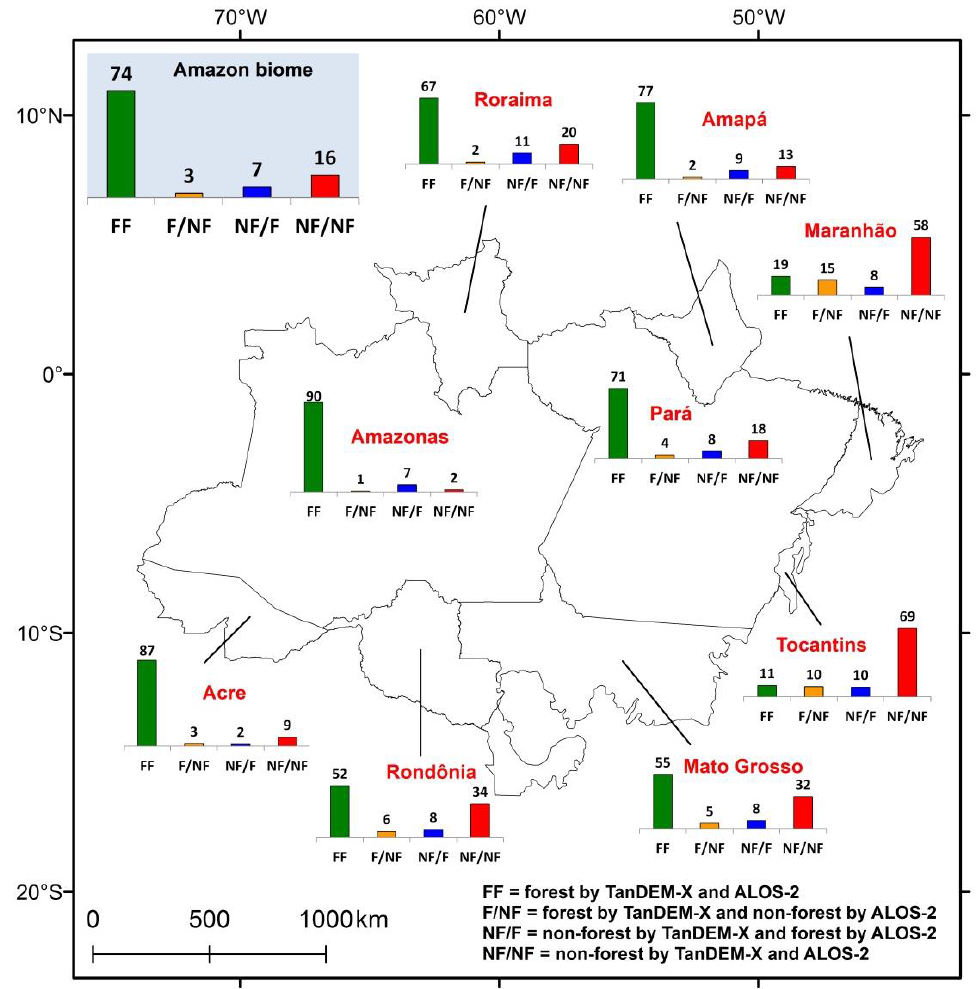
Figure 9. Percentage of pixels classified by the TanDEM-X and ALOS-2 as: forest (FF); non-forest (NF/NF); forest and non-forest (F/NF); and non-forest and forest (NF/F) over the states covered by the Amazon biome.